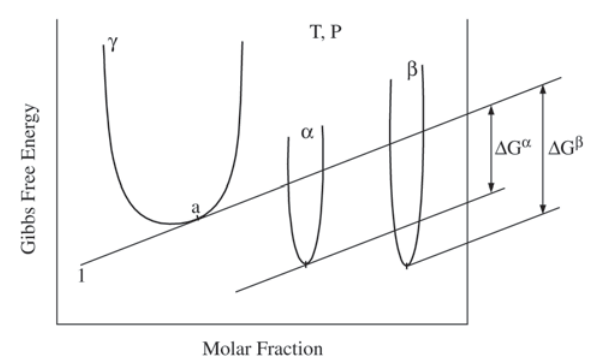
Figure 1. Schematic representation of the driving forces of nu- cleation.